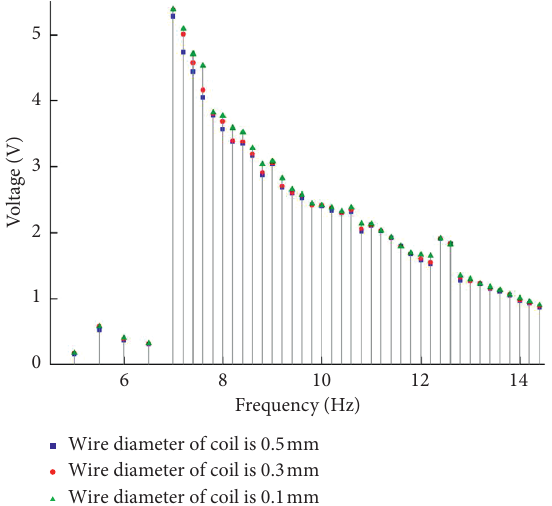
Figure 37: Relation of the voltage-frequency of the system is given when wire diameters of coils are selected as 0.1mm, 0.3mm, and 0.5mm,